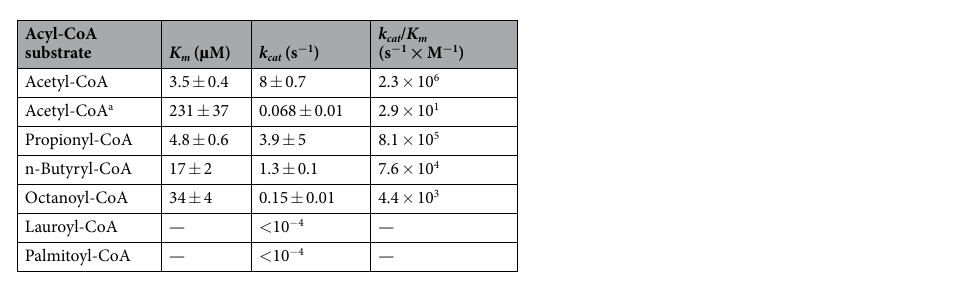
Table 3. Kinetic constants for So YbgC-catalyzed hydrolysis of acyl-CoAs at pH 7.5 and 25 °C. a Performed with So YbgC D15N